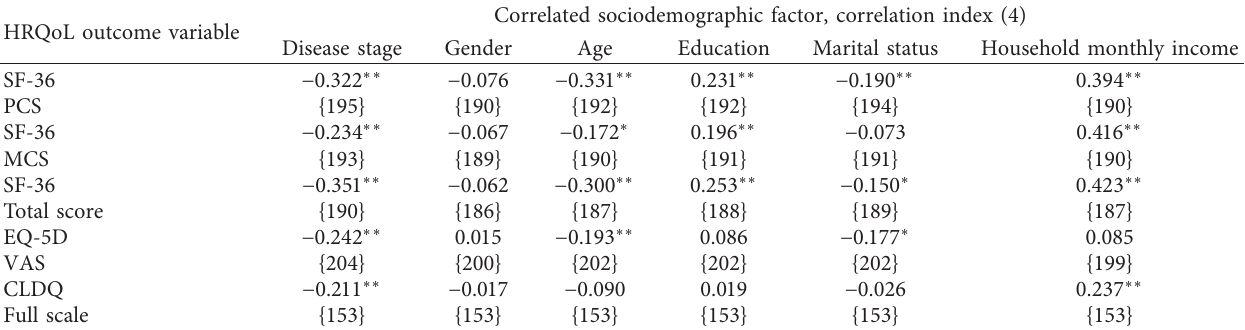
Table 5: Correlation analysis of sociodemographic factor variable influences on HRQoL outcome